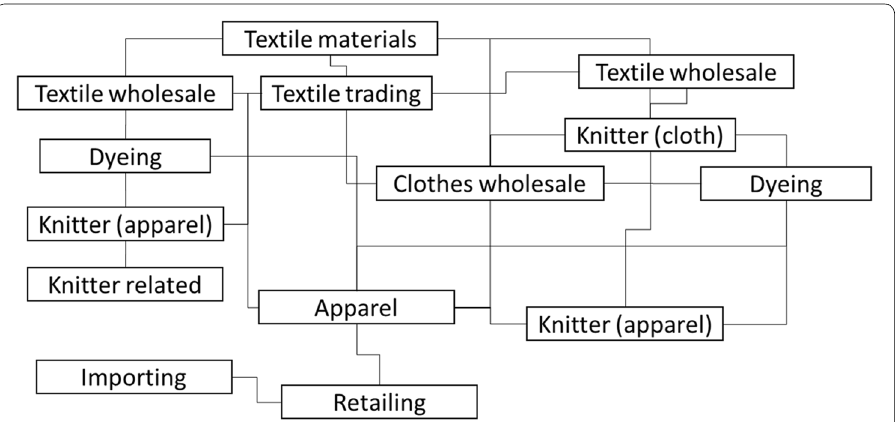
Fig. 1 The conceptual structure of the Japanese textile and apparel